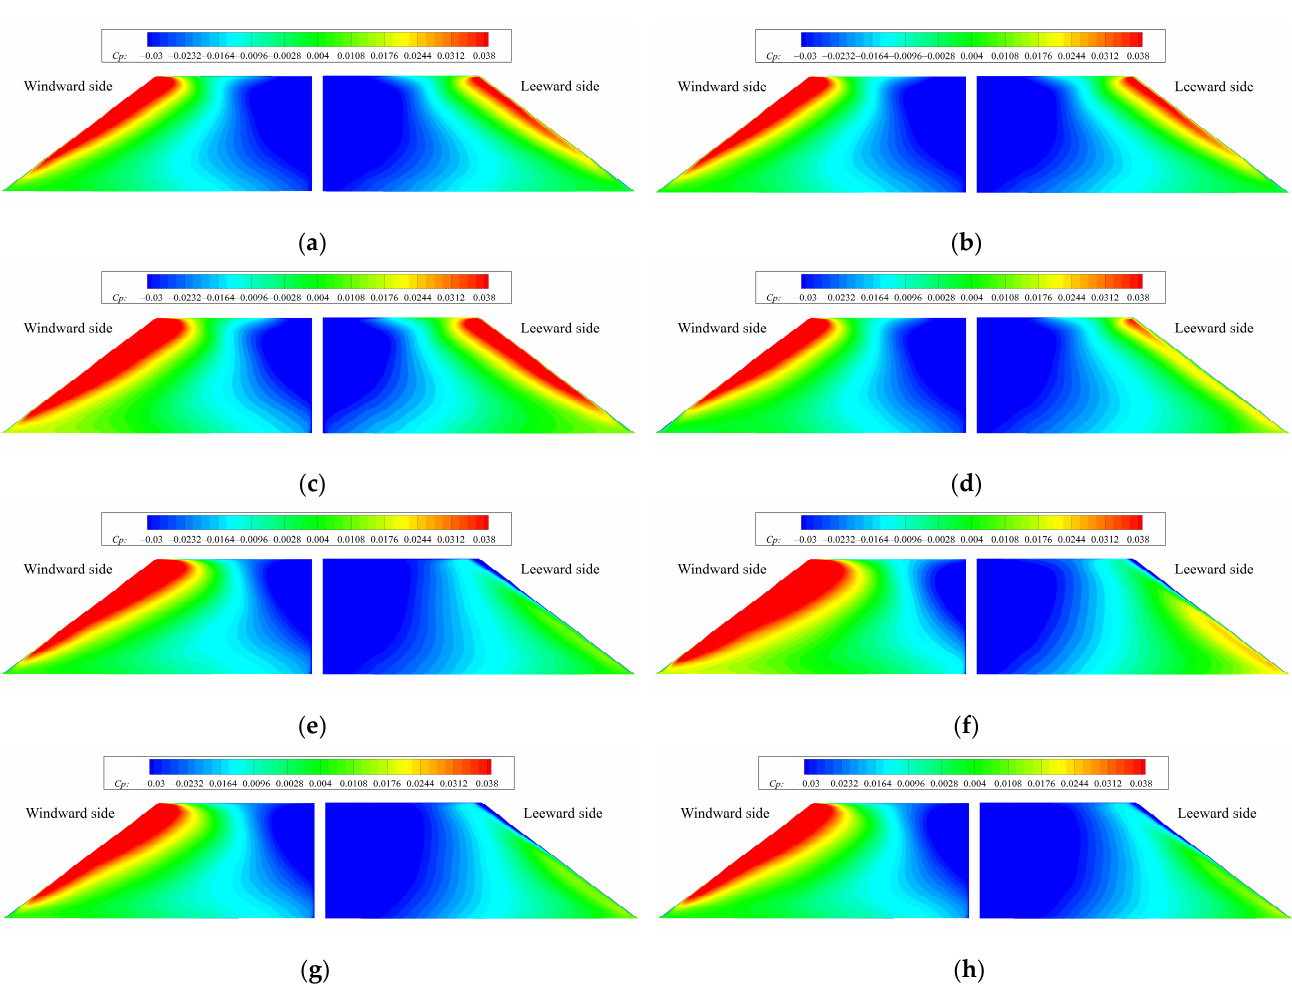
Figure 20. Pressure coefficient contours on the windward and leeward surfaces of Fin1 at different times since lateral jet startup: ( a ) t = 0.1 ms; ( b ) t = 0.2 ms; ( c ) t = 0.3 ms; ( d ) t = 0.4 ms; ( e ) t = 0.5 ms; ( f ) t = 1.0 ms; ( g ) t = 2.0 ms; ( h ) t = 3.0